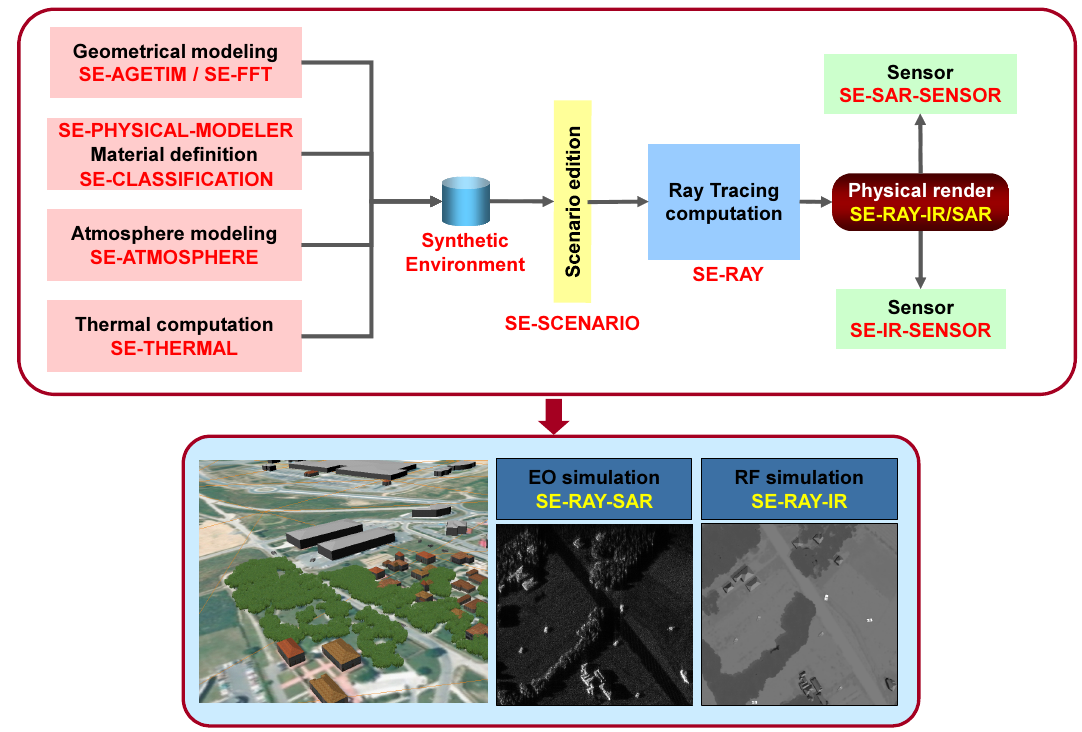
Figure 4. Simultaneous SAR and IR image generation flow using the OKTAL simulation environment